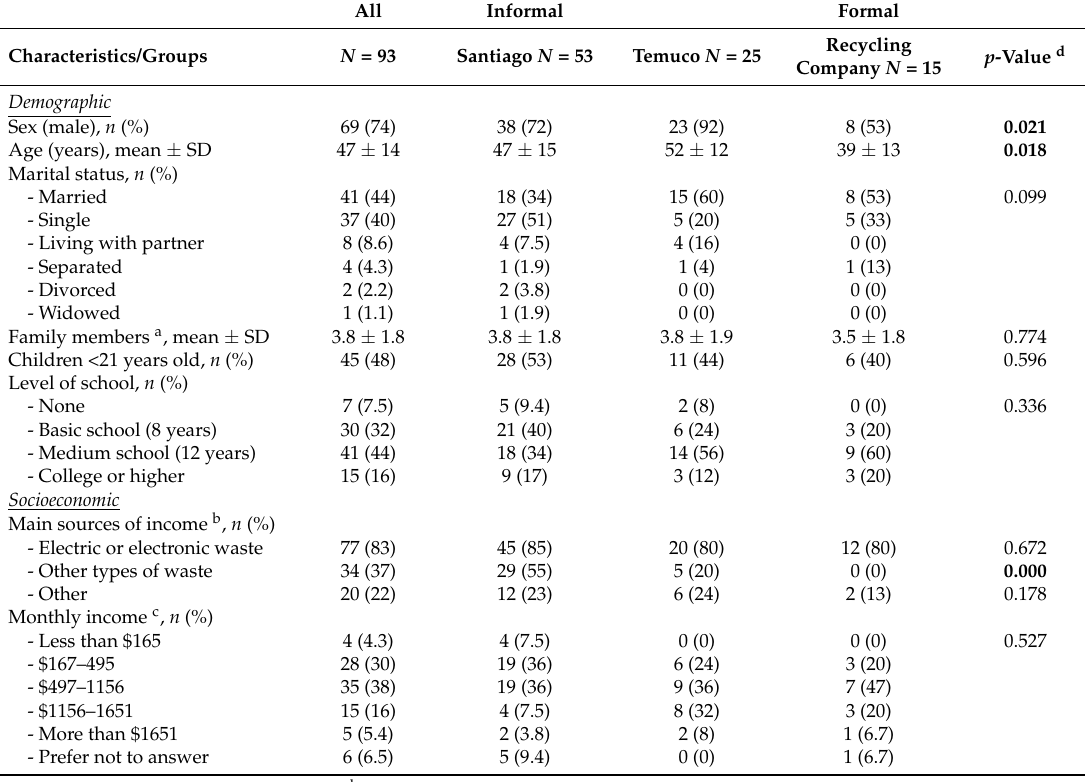
Table 2. Sociodemographic characteristics of the study population, by job type and site.